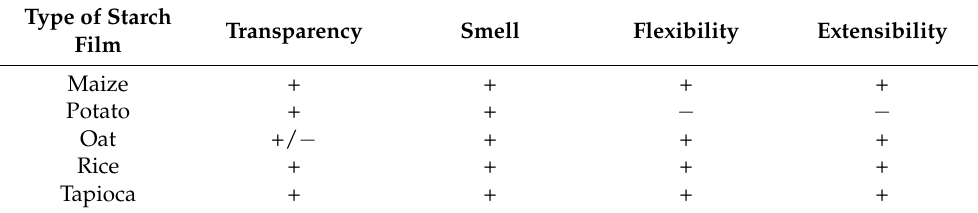
Table 2. External features of various starch